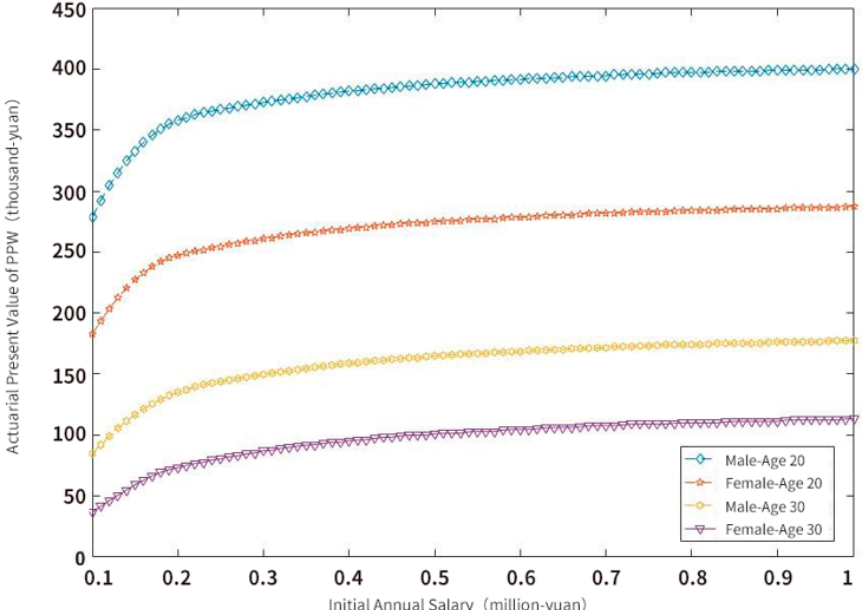
Figure 11. The impact of different initial annual salaries of the insured persons on the present value of PPW.